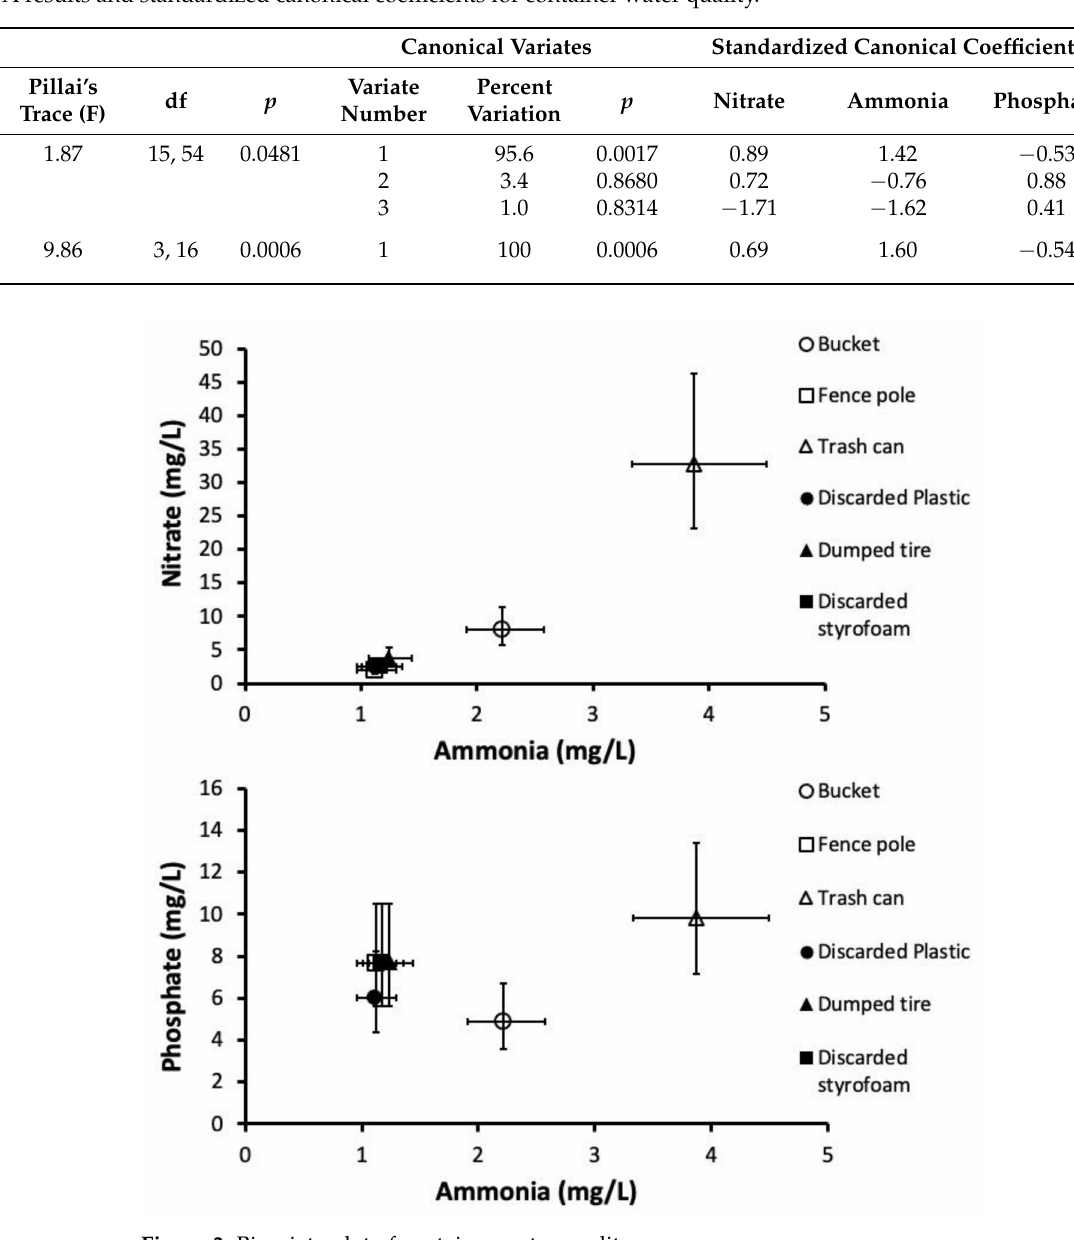
Figure 3. Bivariate plot of container water